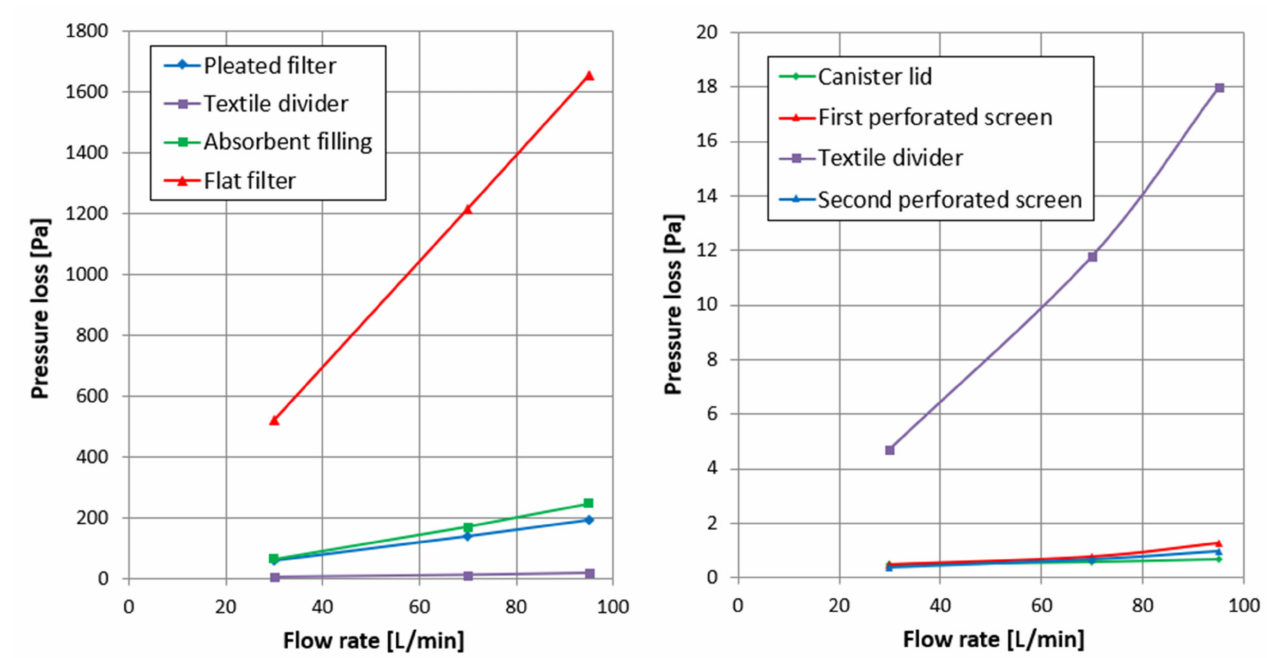
Figure 5. Measured pressure losses in combined filter components.